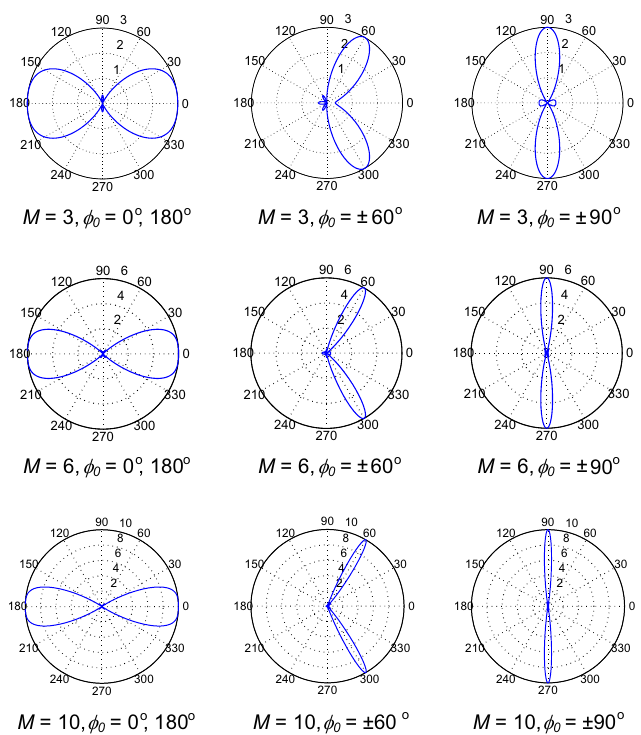
Figure 2. Gain patterns of ULA as the numbers of antenna elements and main beam directions are varied.